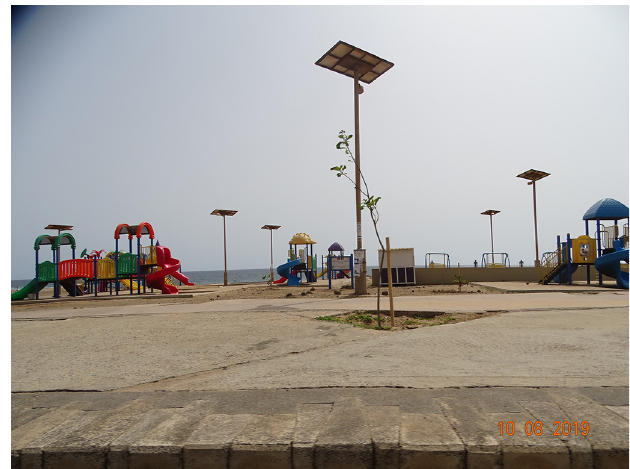
Fig. 9. Public lighting with broken battery system Dakar (cid:1) Senegal (PhotoJ. Kenfack).